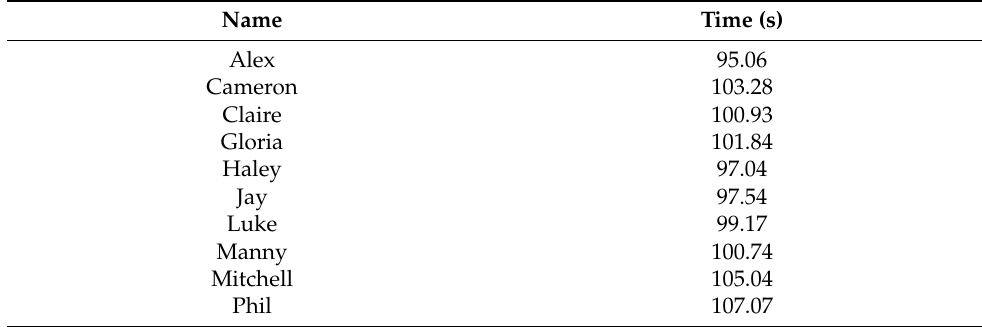
Table 1. The total length of audio recordings sampled for each character in the Modern Family series.